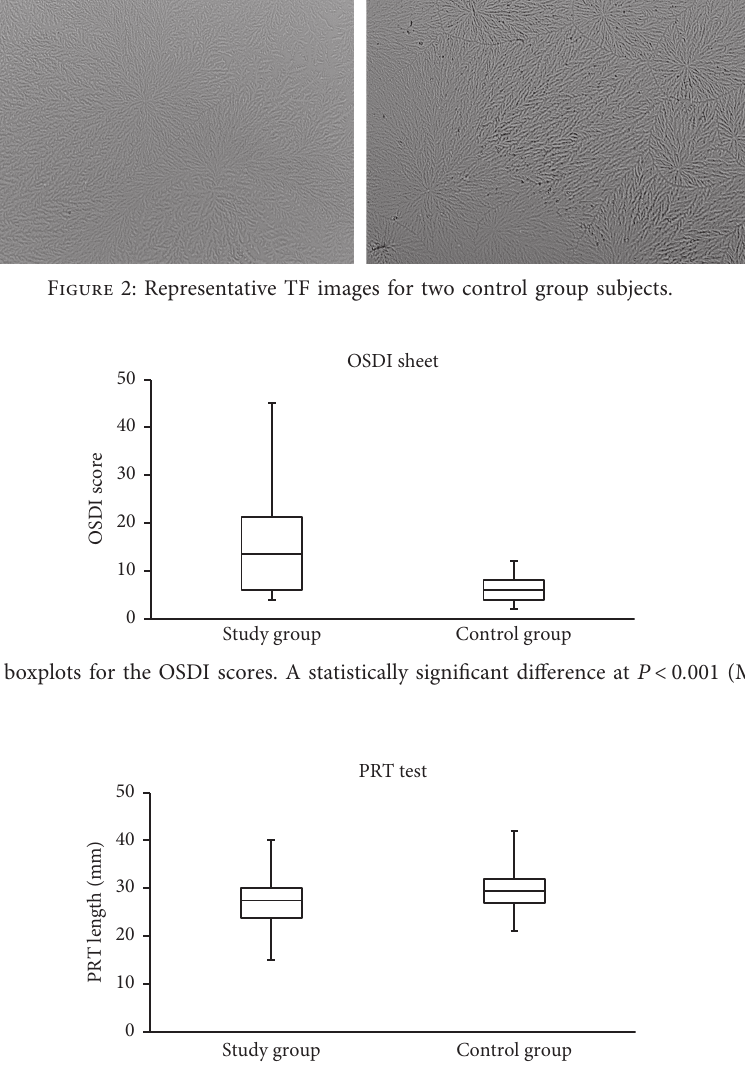
Figure 4: Side-by-side boxplots for the PRT scores. A statistically significant difference was found at P � 0 . 003 (Mann–Whitney